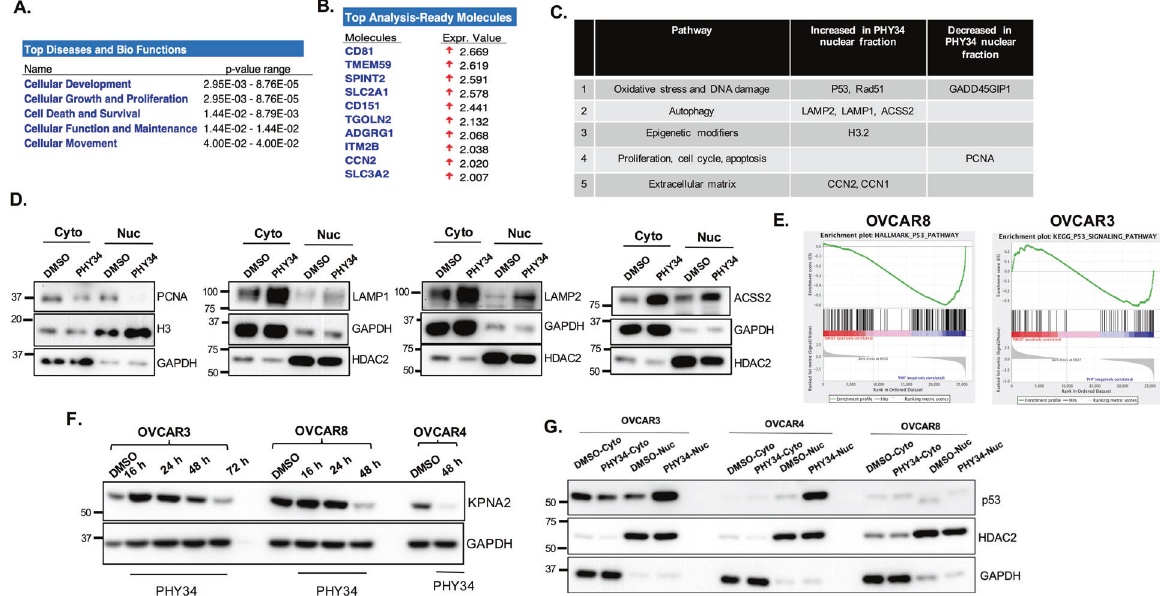
OVCAR3 cells. B Ingenuity pathway analysis of nuclear-cytoplasmic proteomics showing differential expression of proteins after PHY34 (100 nM) treatment in OVCAR3 cells. C List of molecules and pathways from nuclear-cytoplasmic proteomics. D Representative immunoblots for validation of top hits from nuclear-cytoplasmic proteomics. E Gene set enrichment plots showing changes in p53 signaling pathway altered by PHY34 treatment in OVCAR3 and OVCAR8 cells. F Representative immunoblot for KPNA2 expression in HGSOC cells treated with PHY34 at various timepoints. G Representative immunoblot for p53 expression in nuclear and cytoplasmic protein fractions of cells treated with